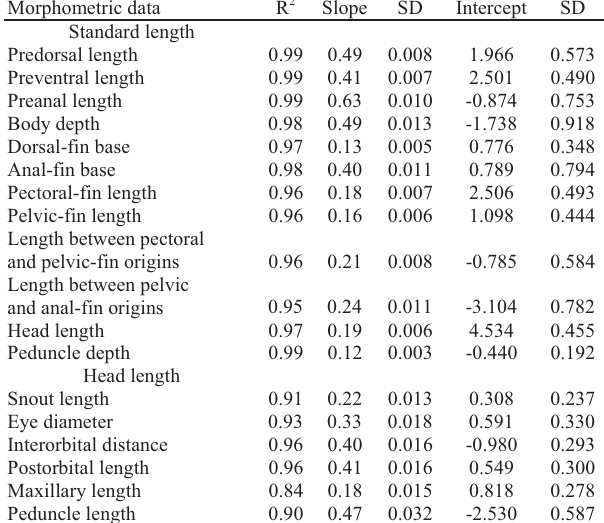
Table 2. Regression statistics for the relationships between morphometric data for A . erythropterus . Slope differences between juveniles and adults were not-significant for all attributes ( t -Test; p < 0.05). R 2 = determination coefficient; SD = standard